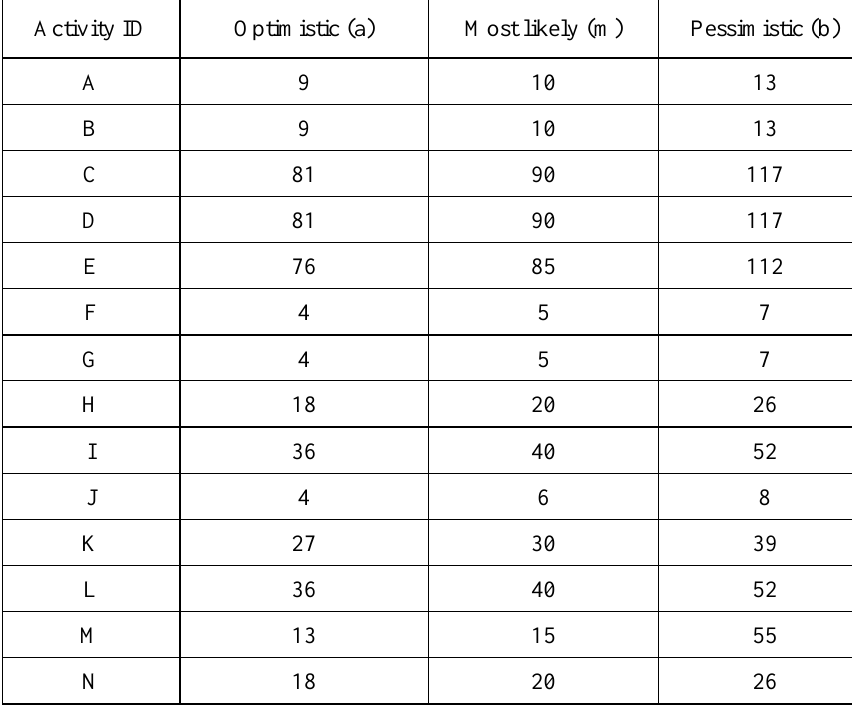
Table 4. Time Estimate for Risk Analysis (developed by the author) Activity